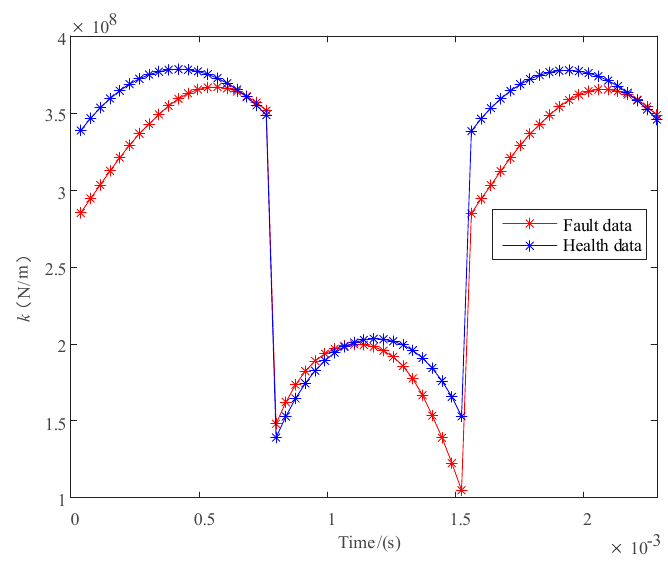
Figure 12. TVMS under healthy and fault conditions.